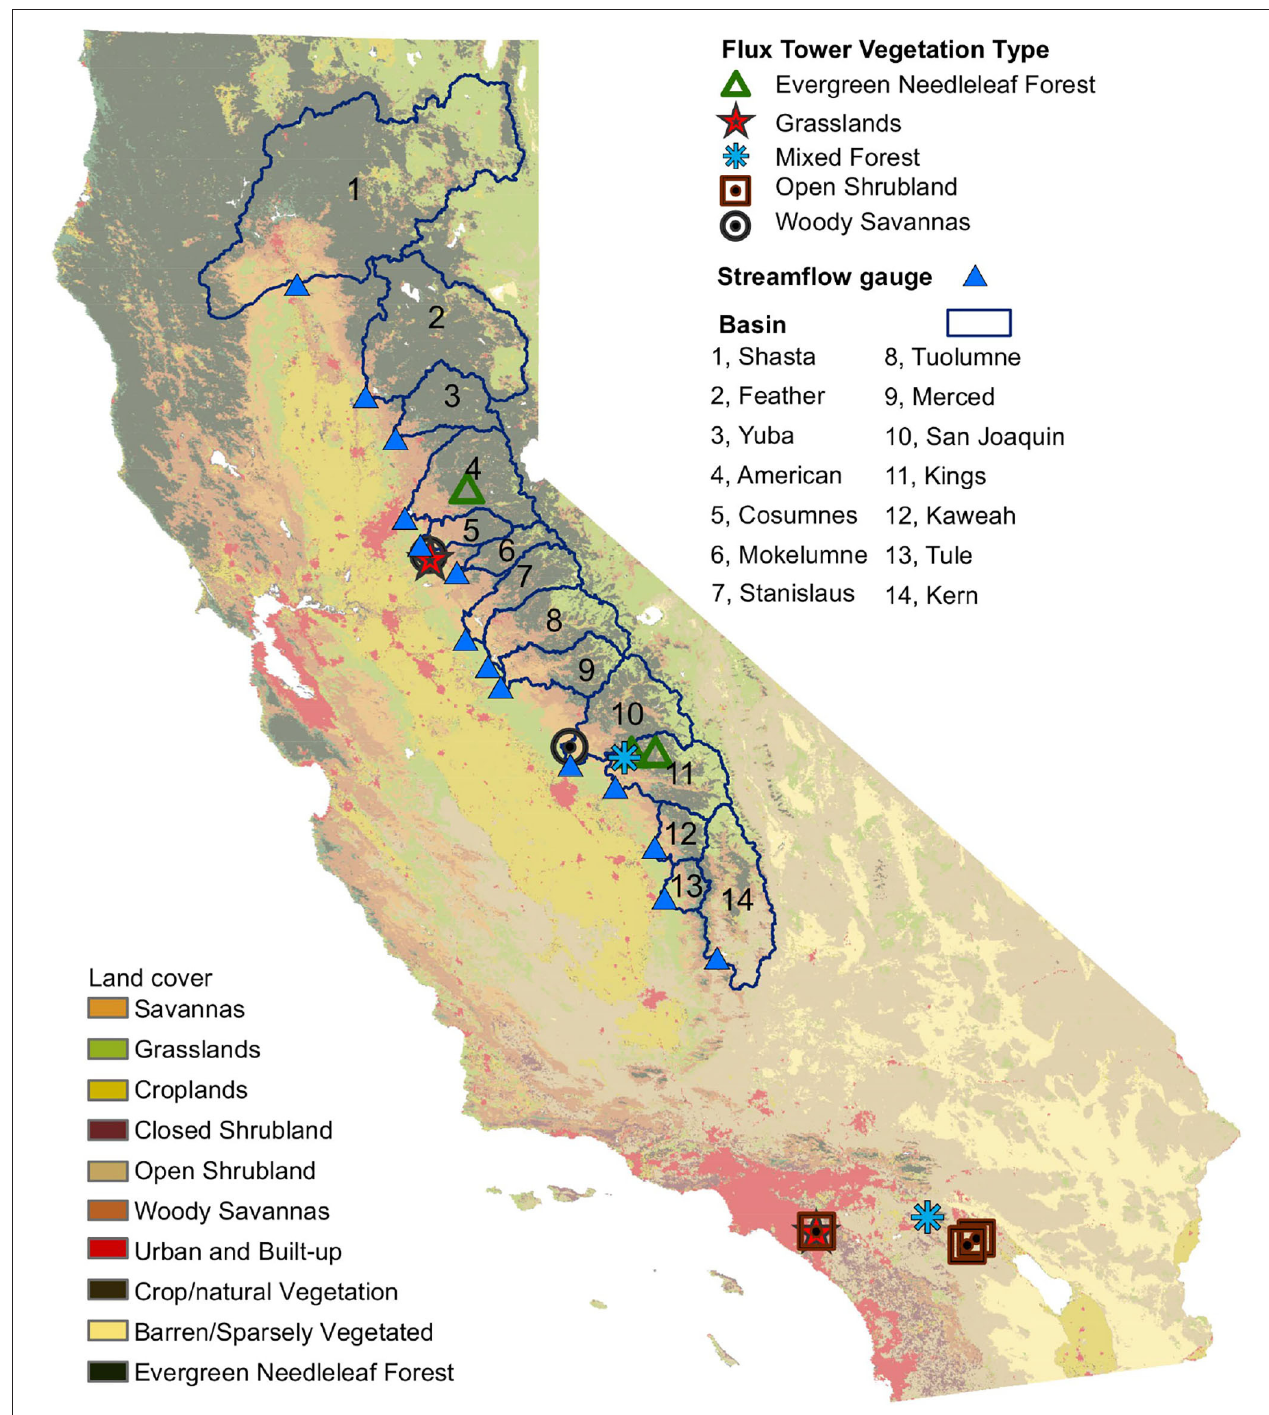
FIGURE 1 | Study area showing locations of flux towers and land-cover classification, unimpaired streamflow gauges, and delineated river basins. The background shows the International Geosphere-Biosphere Programme land cover types.